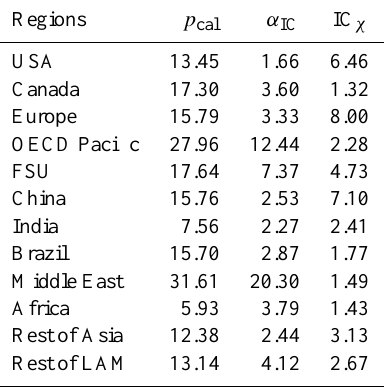
Table 8. Calibrated calorie price p cal value in 2001 ($Mkcal − 1 ), calibrated initial slope of the production function α IC in $Mkcal − 1 and GTAP 2001 intermediate consumption IC χ in billions of dollars Regions p